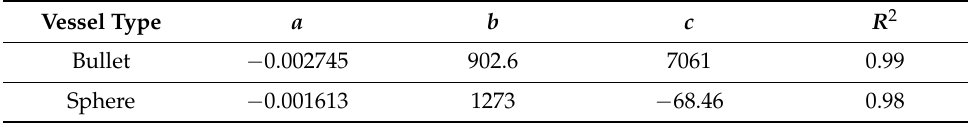
Table 5. The coefficients of Equation (5) for pressure vessels.